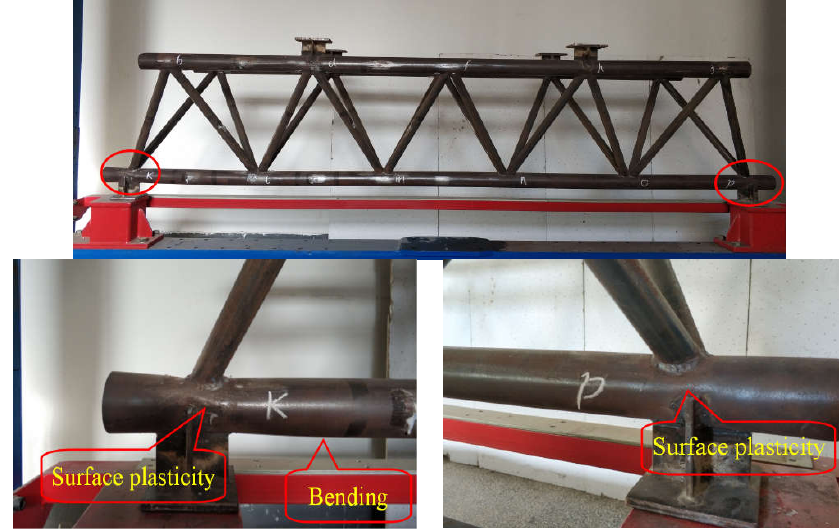
Figure 5. Failure modes of specimen T-HW.